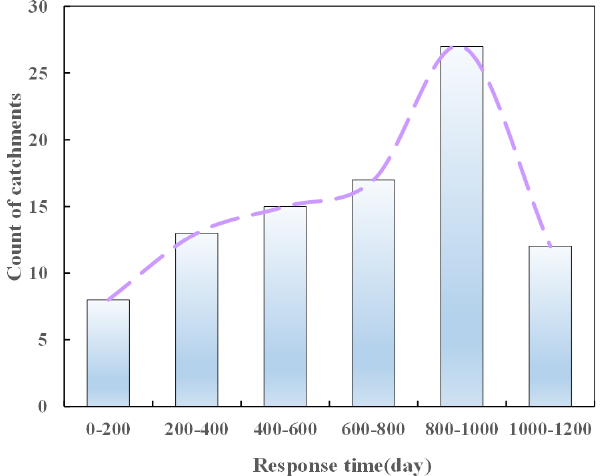
Figure 8. Magnitude distribution of the response time in 92 catch- ments that satisfied the basic criteria of NSE performance and result